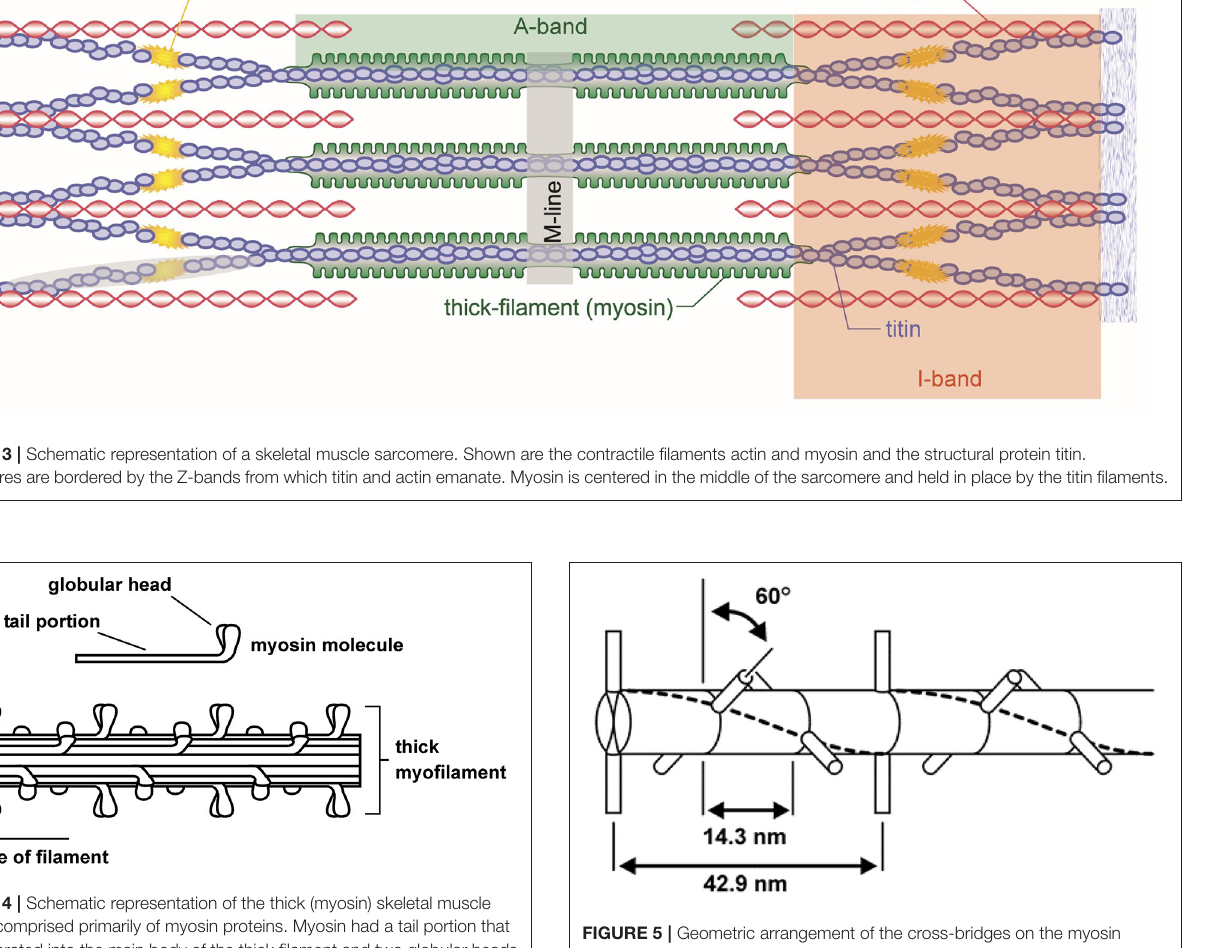
FIGURE 5 | Geometric arrangement of the cross-bridges on the myosin filament. Cross-bridges come in pairs that are offset by 180 ◦ and are arranged every 14.3nm along the myosin filament. Neighboring pairs of cross-bridges are rotated by 60 ◦ ; therefore, cross-bridges with the same orientation (and thus attaching to the same actin filaments) occur every